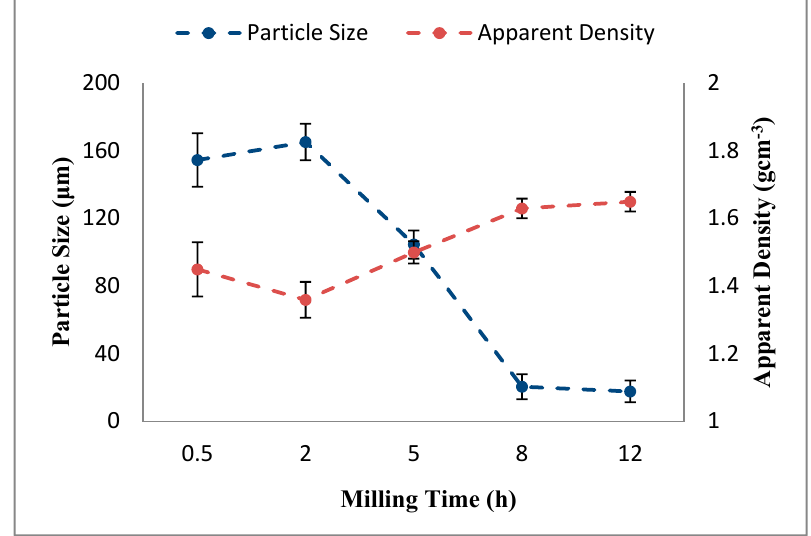
Figure 3. The variation of particle size and apparent density of Al-5Al 2 O 3 nanocomposite powders as a function of the milling time.